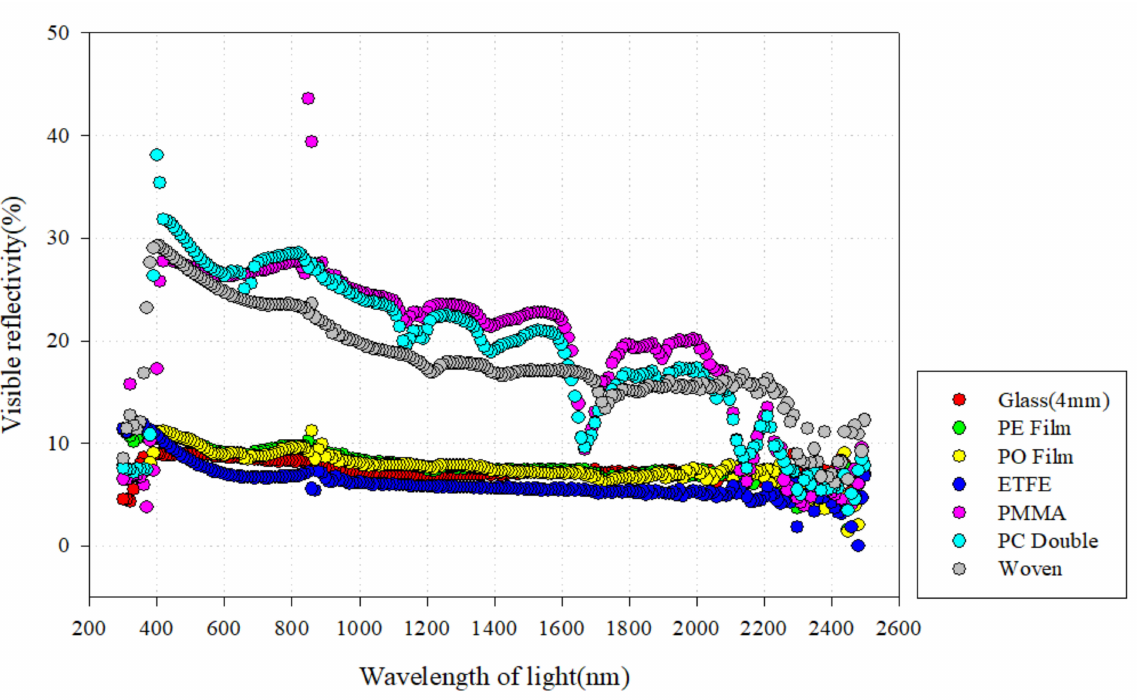
Figure 13. Comparison of visible reflectivity by